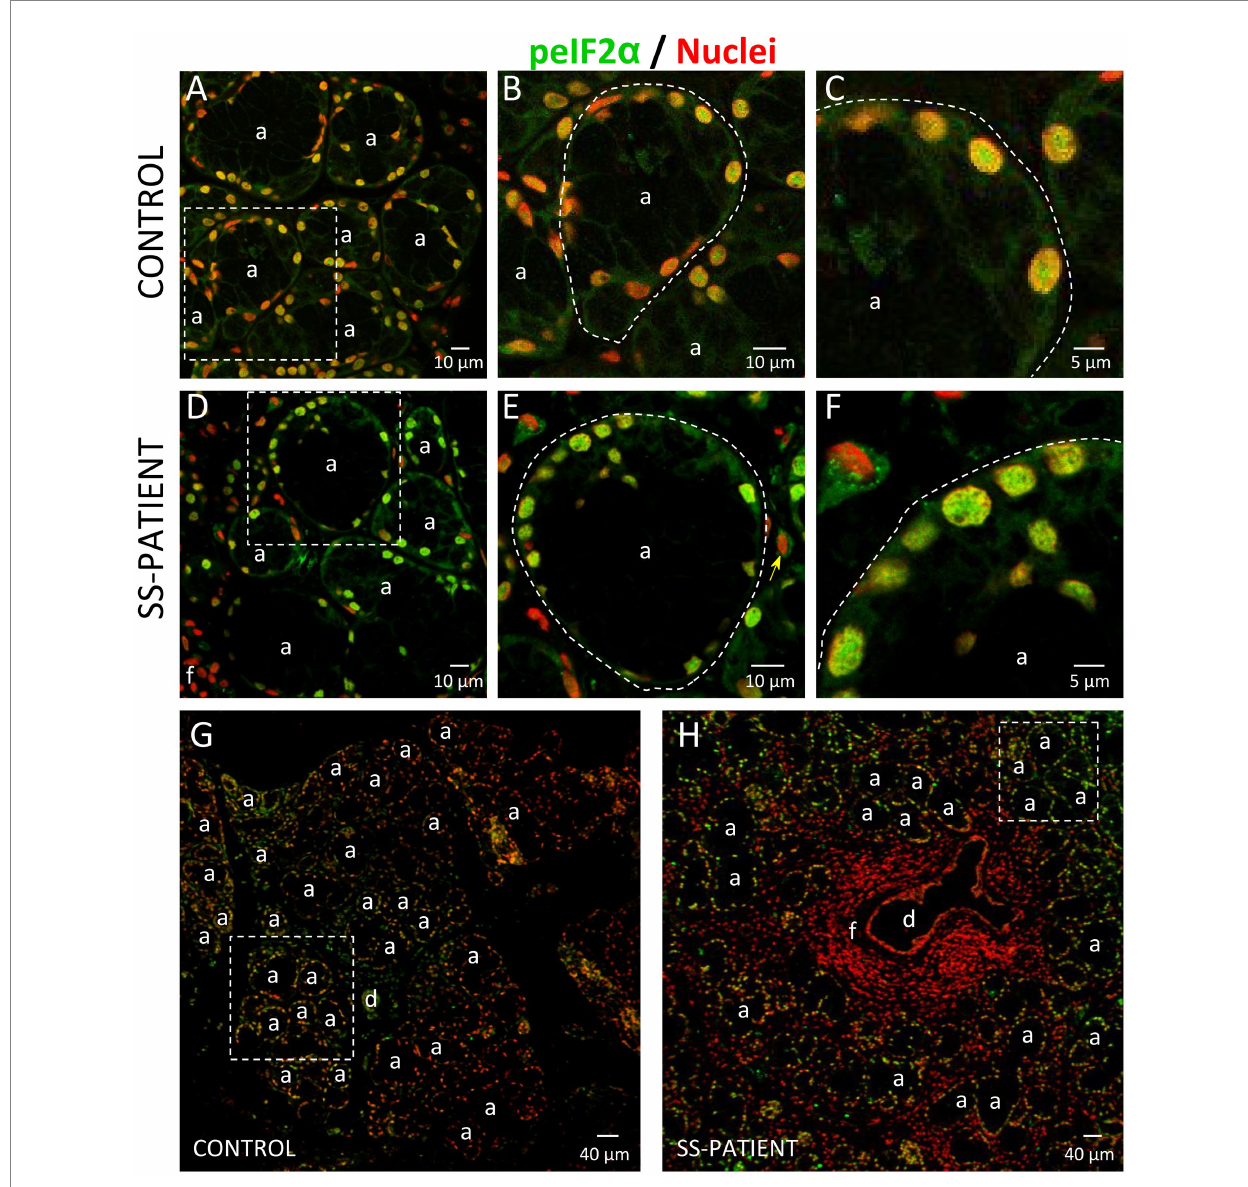
FIGURE 10 Localization of p-eIF2 α in LSGs from controls and SS-patients. (A–C,G) p-eIF2 α (green) staining was mainly observed in the nuclei of epithelial cells in LSGs from control subjects. (D–F,H) stronger p-eIF2 α (green) staining was observed in the nuclei of epithelial cells in LSGs from SS-patients. (A,D) Higher magnifications of regions surrounded by broken lines in G and H, respectively. (B,C,E,F) Higher magnifications of regions surrounded by broken lines in A and B, respectively. Nuclei (red) were counterstained with Hoechst-33342. a: acini; d: duct; f: focus of inflammatory cells. Bars A, B, D and E: 10 μ m; C and F: 5 μ m; G and H: 40 μ